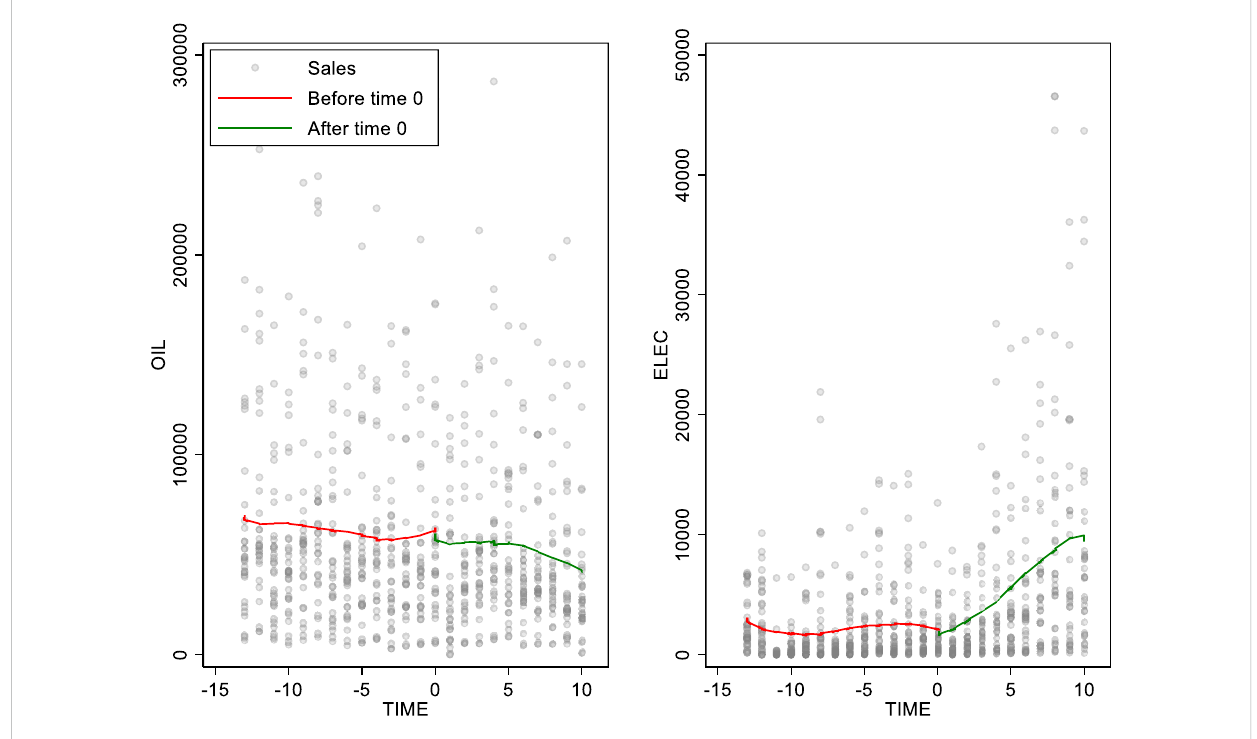
FIGURE 2 Relationship between COVID-19 pandemic shock and the consumption of traditional- and new-energy